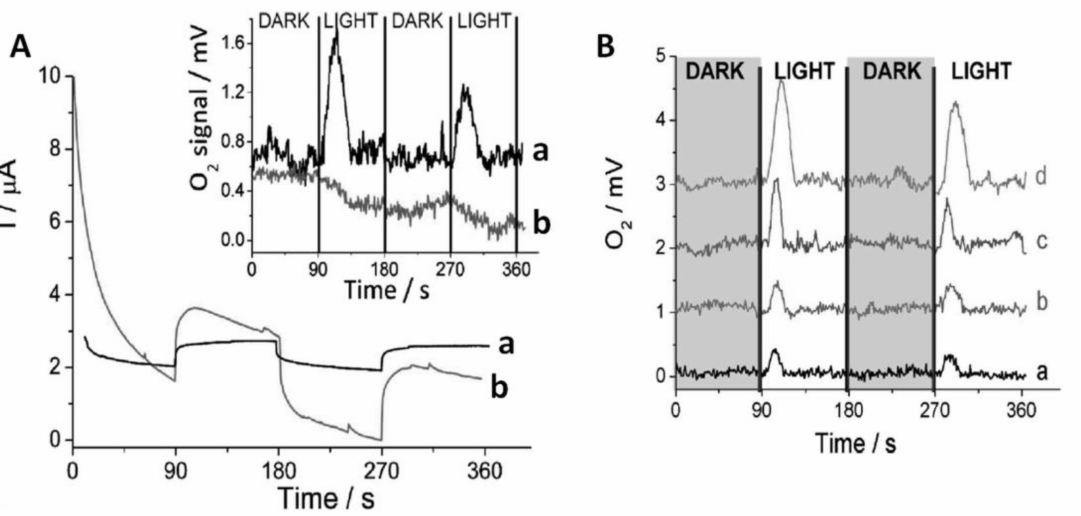
Figure 12. ( A ) Photoelectrochemical data obtained with FTO/SnS 2 /ITOnp electrodes, polarized at 1V vs. SHE: (a) with laccase enzyme; (b) without it. The inset presents the simultaneous O 2 generation in this experiment. ( B ) O 2 sensor signal for FTO/SnS 2 /laccase/ ITOnp electrodes when polarized at (a) 1 V, (b) 0.8 V, (c) 0.6 V, and (d) 0.4 V vs. SHE. Alternating dark/light periods were used in all cases (Adapted from Ref.